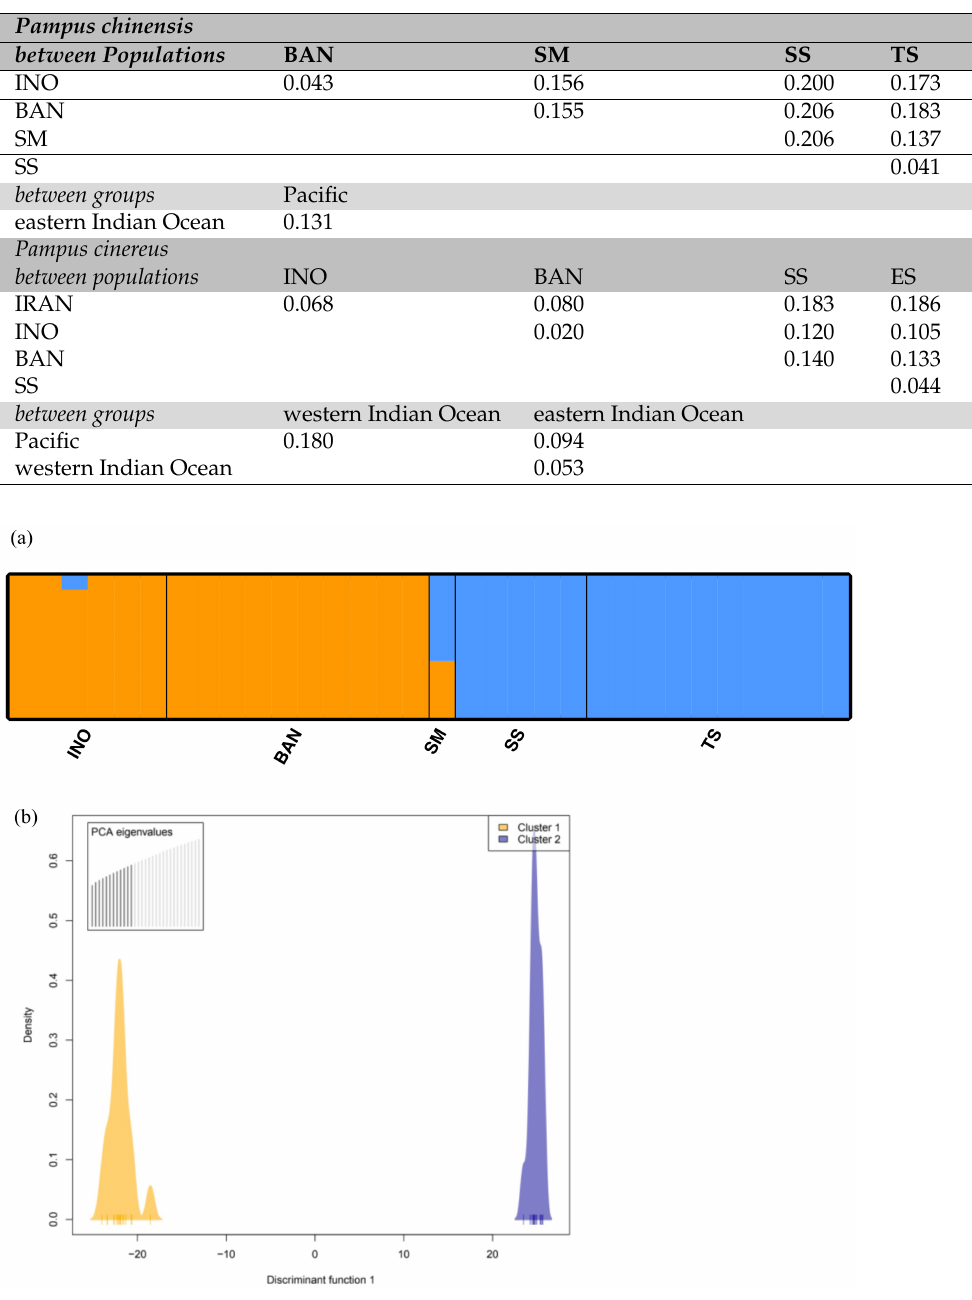
Table 3. Mean pairwise F ST values between populations and between groups. INO denotes the Indian Ocean population, IRAN the Arabian Sea population, BAN the Bay of Bengal population, SM the Strait of Malacca population, SS the South China Sea population, TS the Taiwan Strait population and ES the East China Sea population. For P . chinensis , the group of eastern Indian Ocean contains BAN and INO and SM; the group of western Pacific contains SS and TS. For P . cinereus , the group of western Indian Ocean contains IRAN, the group of eastern Indian Ocean contains INO and BAN and the group of western Pacific contains SS and ES.